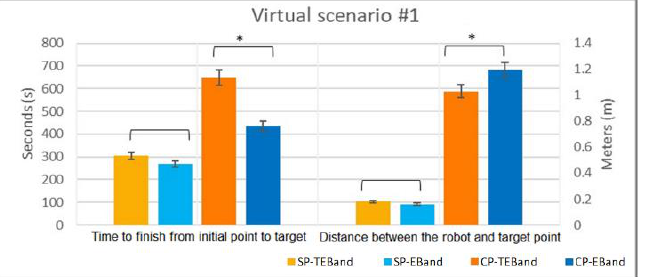
Figure 15. Comparison of time to finish and error among experimental groups using the hospital scenario (* p < 0.05).